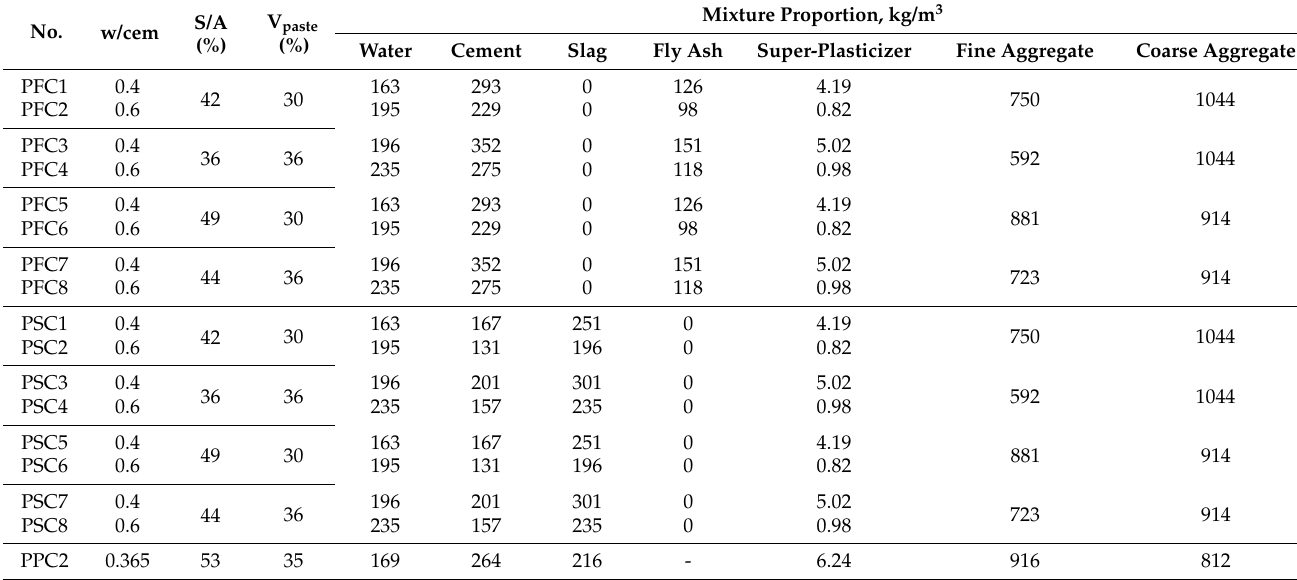
Table 8. Pozzolanic concrete mixture proportions collected from the relevant studies for verifying the applicability of the unified